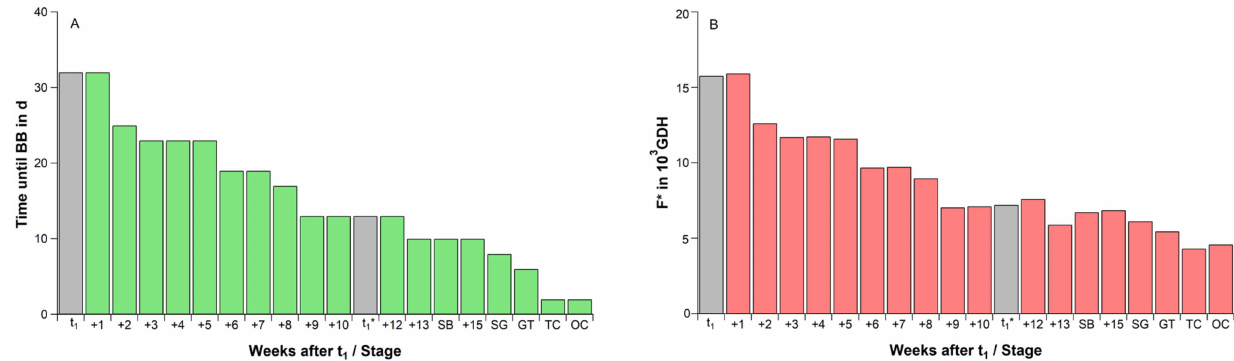
Figure 1. ( A ) Time until beginning of cherry blossom (BB) in days (d) and ( B ) forcing requirement between sampling and blossom (F* in GDH) for weekly sampling dates after t 1 under controlled conditions ( ∼ 24 ◦ C, 12 h light, 70% relative humidity), 2018/19 season. t 1 : endodormancy release, t 1 *: beginning of ontogenetic development. With beginning of bud development, sampling was done with development orientated at SB: ‘swollen bud’, SG: ‘side green’, GT: ‘green tip’, TC: ‘tight cluster’, OC: ‘open cluster’.